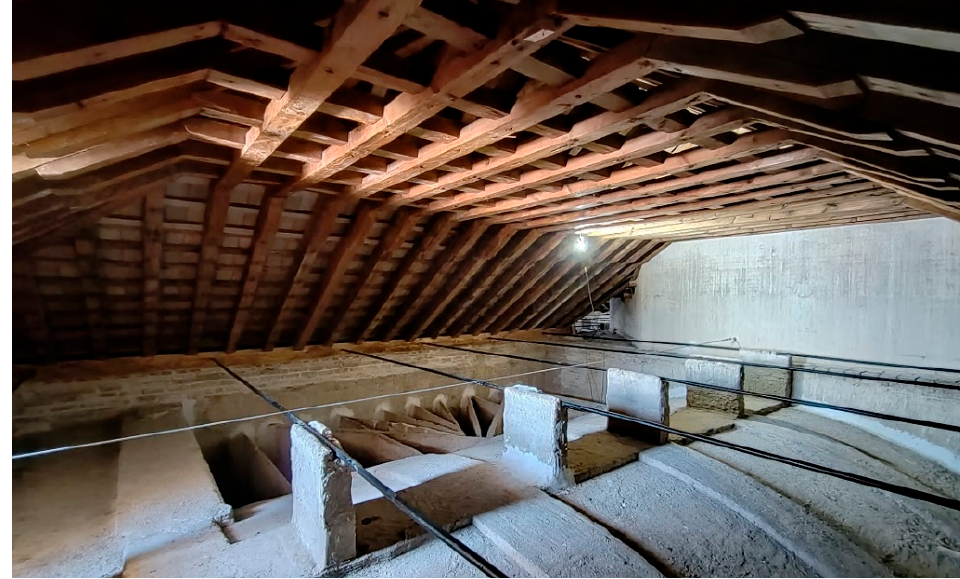
Figure 7. Timber frame structure under the roof and over the suspended brick vault.